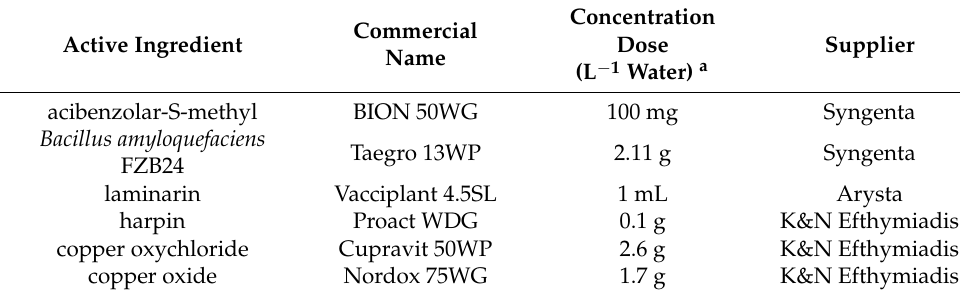
Table 1. Products evaluated in this study for their efficacy against olive leaf spot disease.